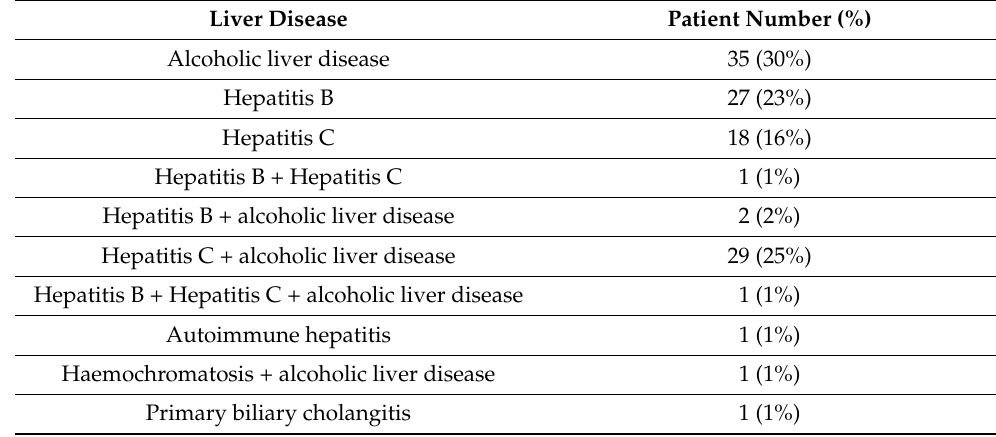
Table 2. Underlying liver disease in non-NAFLD-HCC